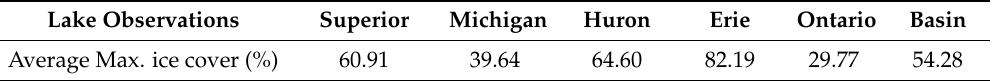
Table 1. Average annual maximum ice cover for the period 1973–2018.